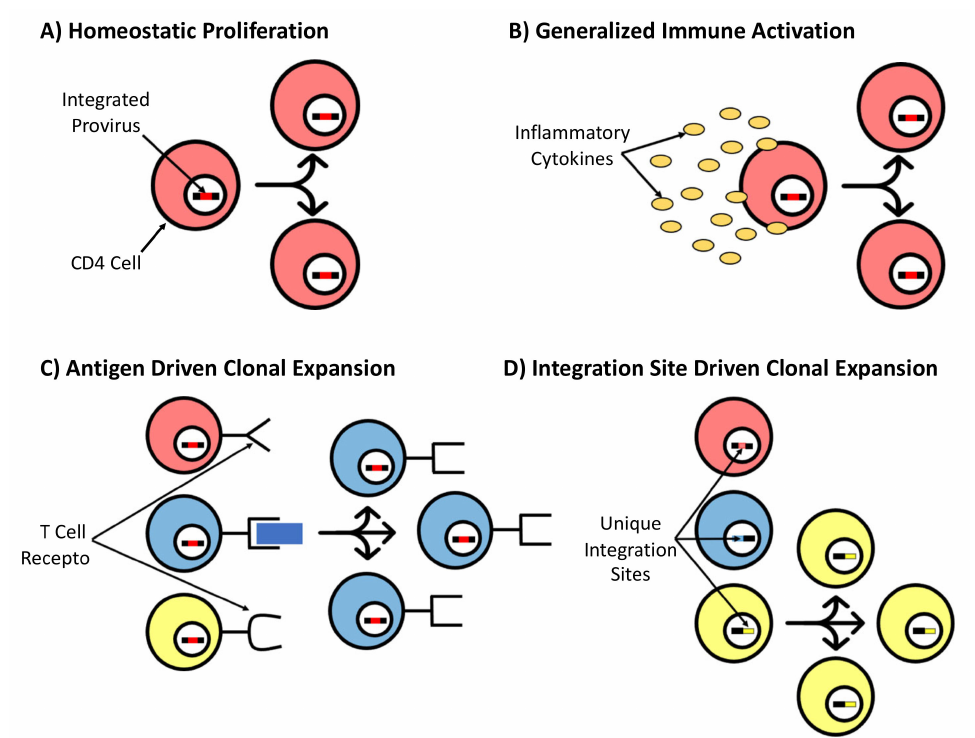
Figure 4. Mechanisms of clonal expansion. ( A ) Homeostatic proliferation maintains existing CD4 T cells. ( B ) Generalized immune activation can stimulate CD4 T-cell proliferation. ( C ) Antigen-binding to a CD4 T-cell receptor can stimulate clonal expansion. This stimulus for clonal expansion can create larger clones than the other mechanisms. ( D ) In rare instances, the site of proviral integration into the host genome can stimulate clonal